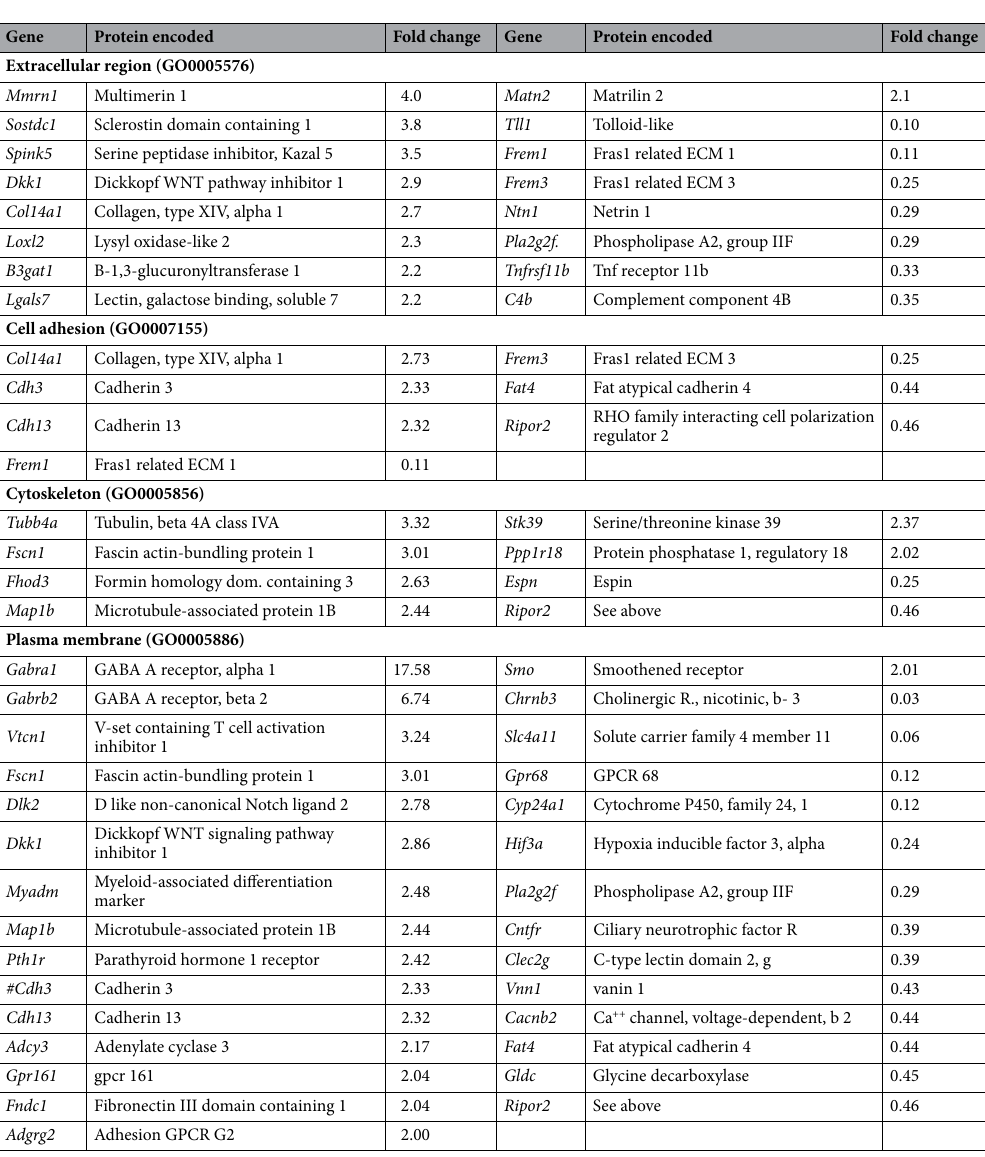
Table 2. Gene ontology (GO) enrichment analysis. Genes with significantly altered expression were subjected to gene ontology analysis. GO categories name and code are in the table in bold. GABA gamma amino butyric acid, GPCR G protein coupled receptor, ECM extracellular matrix, TNF tumor necrosis factor, R receptor, Dom.